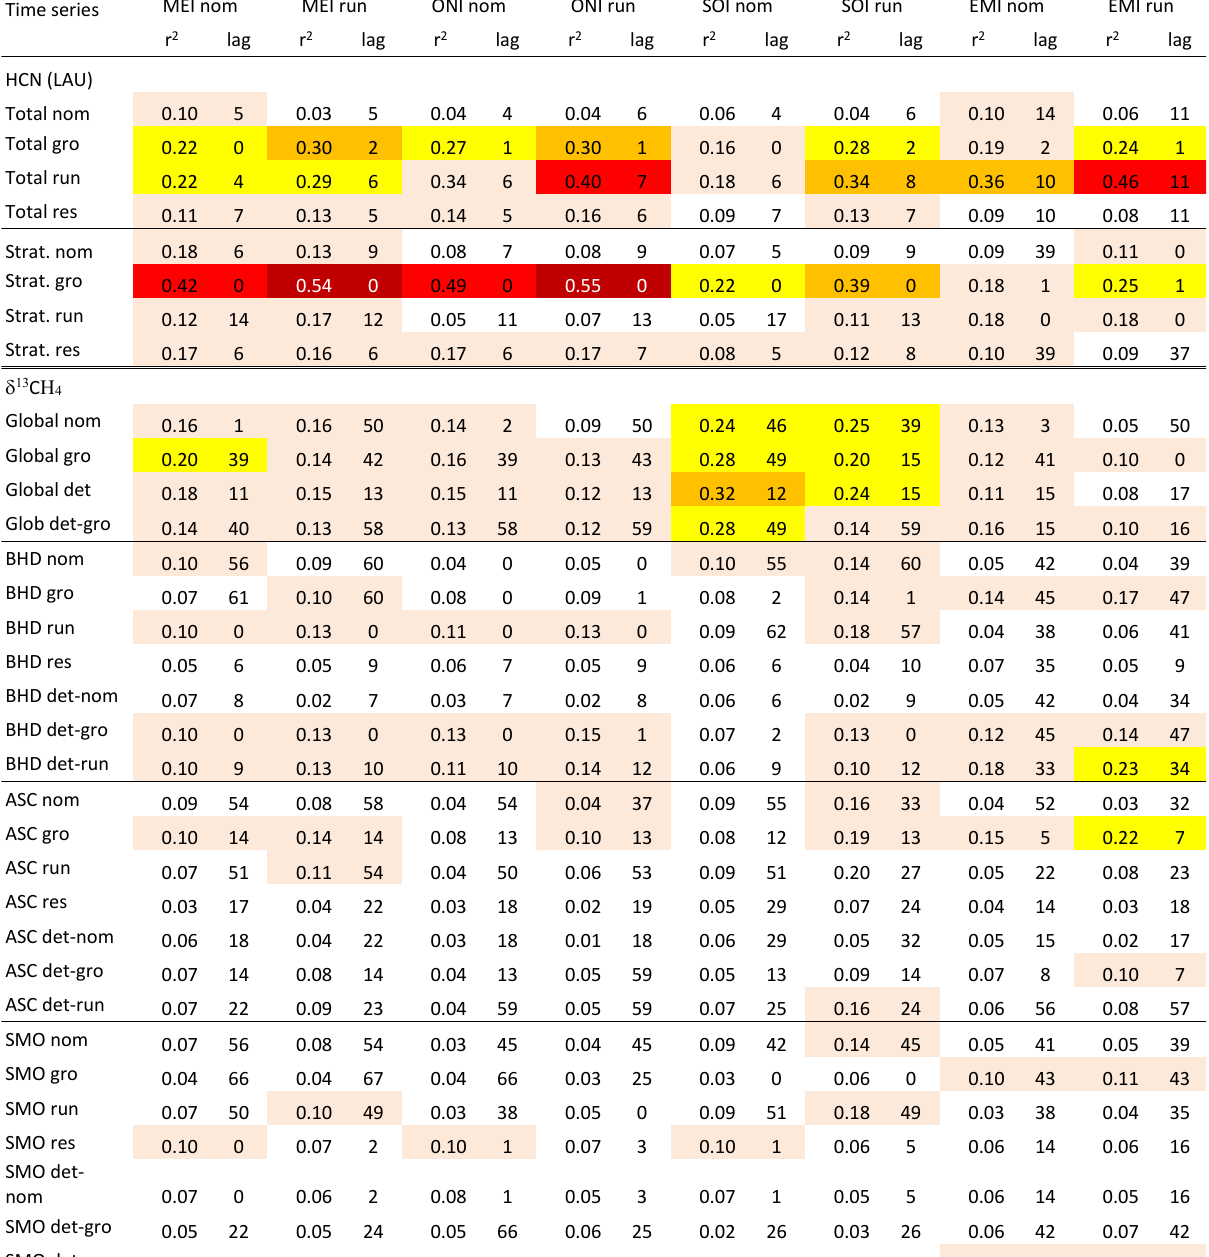
Table 4. Pearson correlation of δ 13 CH 4 and HCN with ENSO variability. Correlations ( r 2 values) for the Pearson correlation coefficient between dependent variables, i.e. δ 13 CH 4 and HCN time series from various sites, and ENSO indices with lag times (in months) for optimum results. Colour backgrounds indicate r 2 values in 10% classes. Results have not been screened for p